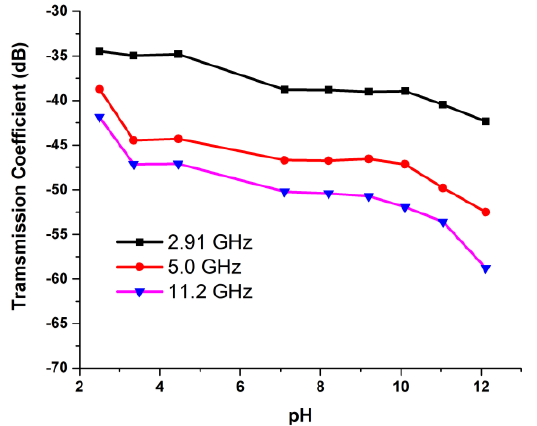
Figure 16. Measurement setup of the proposed UWB antenna sensor.